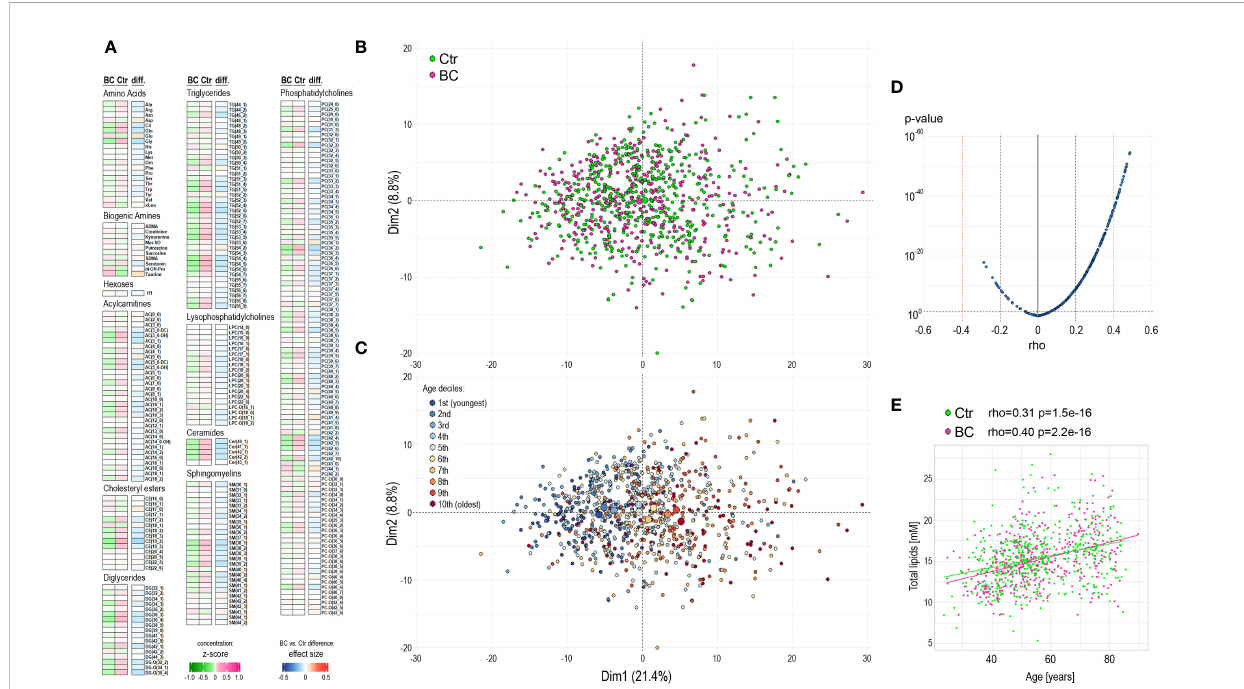
FIGURE 1 Characterization of the serum metabolome pro fi le in participants of the HUNT2 study. (A) – Levels of metabolites in pre-diagnostic serum samples from 453 participants who were diagnosed with breast cancer during 15-year follow-up (BC) and 453 age-matched women who remained cancer- free during this time (Ctr); heatmap represents average levels of analyzed metabolites in each group (represented as z-score) and signi fi cance of differences between groups (represented as “ r ” effect size). (B) – Principal component analysis (PCA) of general similarities between samples; samples of women diagnosed with cancer or remaining cancer-free are marked separately (large circles represent the average for each group). (C) – PCA in a total of 906 samples with subsequent deciles of participant ages marked separately. (D) – the signi fi cance of the correlation between serum metabolite concentrations and the age of study participants (all participants together). (E) – the correlation of aggregated concentration of all analyzed lipids and age of study participants (controls and BC cases are marked